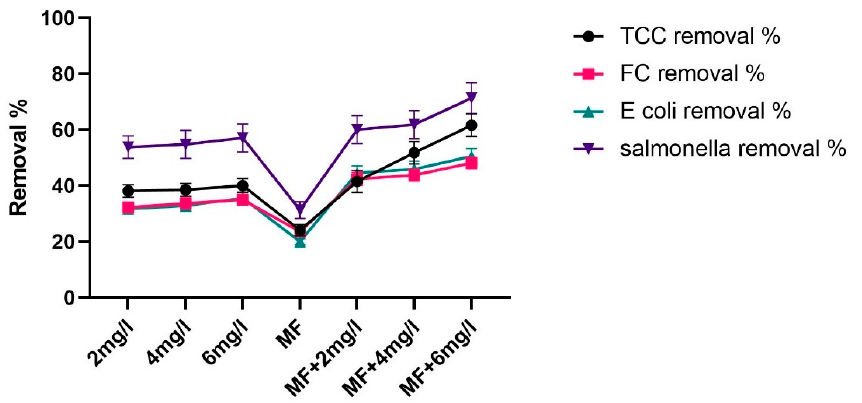
Figure 6. Microbial removal efficiencies of secondary effluents of SHWW treated by different disin- fection methods; (l) 2, 4, and 6 mg/L active chlorine; Disinfection with 12% ( w / v ) commercial NaClO (2) MF: disinfection with magnetic field; and (3) MF + 2 mg/L, MF + 4 mg/L, and MF + 6 mg/L; pretreatment with magnetic field then disinfection with NaClO.